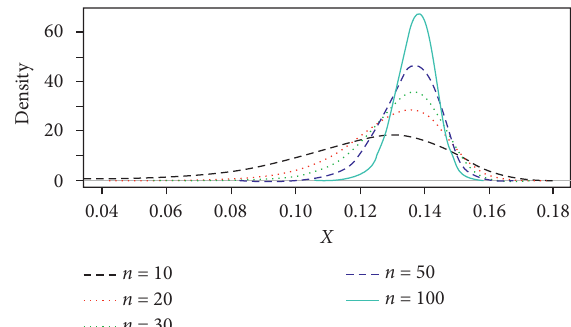
Figure 4: The estimated PDF’s of T w